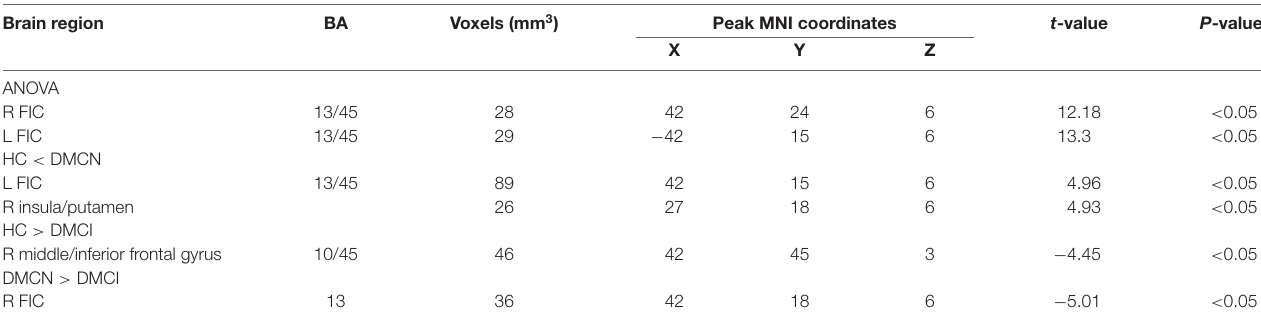
TABLE 2 | Group differences of intra-SN FC among the three groups. Brain region